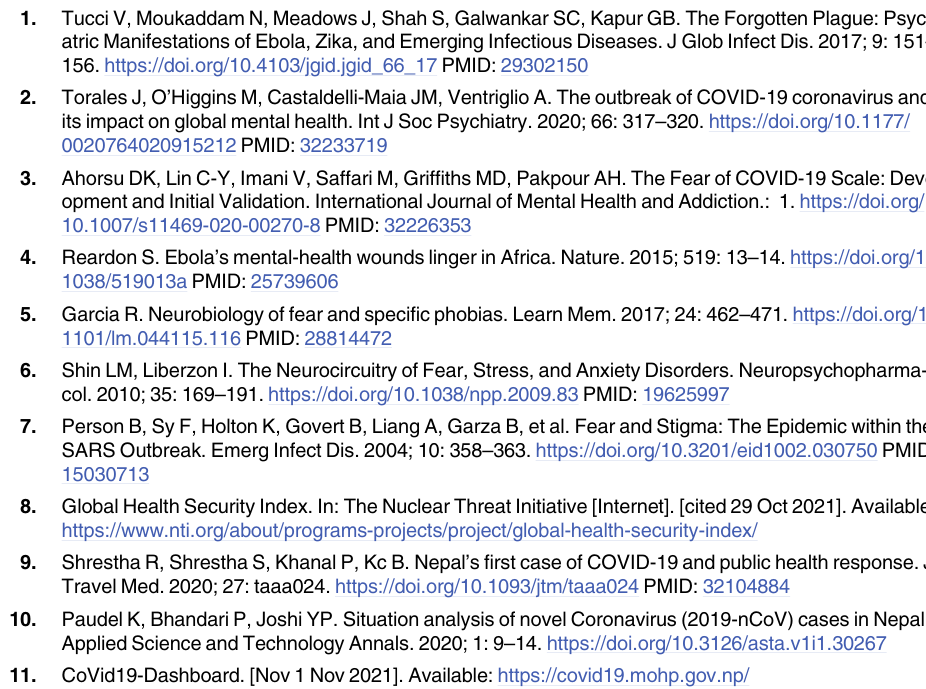
S2 Table. Correlation of FCV-19 S with HADS-A, HADS-D and ISI (N = 475). S3 Table. Fear of COVID-19 and its associated